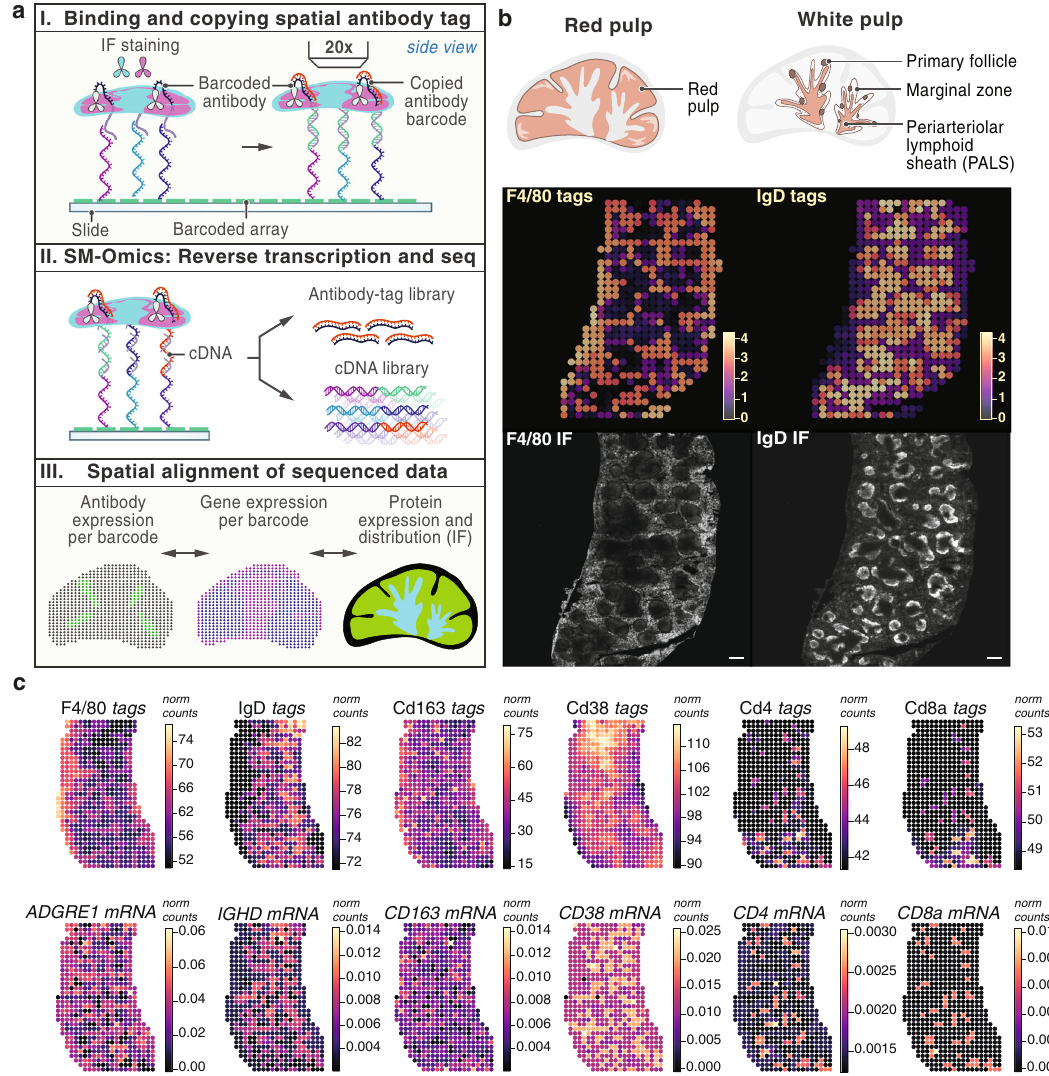
Fig. 4 Spatial RNA-Seq and protein pro fi ling with DNA-barcoded antibodies in mouse splenic tissue. a Experimental setup. SM-Omics approach combines automated imaging of IF antibody stained tissue sections, tagging antigens spatially in situ using DNA-barcoded antibodies and capturing mRNA on a spatially barcoded poly(d)T array. Frozen tissue sections are placed on a SM-Omics array, tissues stained with both IF and DNA-barcoded antibodies, imaged and in situ copying reactions performed and at the same time as cDNA is made (I). Then, both the antibody tags and cDNAs are used in the library preparation reactions and sequenced (II). Finally, spatial IF, antibody tag and gene expression patterns can be evaluated (III). b Performance of combined antibody IF and DNA-barcoded antibody signal measurements. Splenic tissue illustration of red and white pulp structures (top) followed by spatial expression pro fi les of sequenced antibody tags (middle; normalized expression shown in color scale) as well as IF images (bottom) in splenic tissue for F4/ 80 staining red pulp macrophages and IgD staining marginal zone B cells in the white pulp ( n = 7). Scale bar (bottom) denotes 300 µ m. c Performance of combined DNA-barcoded antibody signal and spatial transcriptomics measurements. Spatial expression pro fi les (normalized expression shown in color scale) for a 6-plex SM-Omics reaction with F4/80, IgD, Cd163, Cd38, Cd4 and Cd8a DNA-barcoded antibody-based expression in the top panel (tags) and respective gene expression shown in the bottom panel patterns (Fig. 4b) that were well-correlated to the corresponding both detection methods. We imaged the fl uorescently labeled IF intensities across all major splenic regions (Supplementary epitopes prior to any in situ enzymatic reactions on the array Fig. 10a, on average 76%, p ≤ 0.0001). RNA and antibody tag surface, coupled the antibody tags to the spatial array, such that levels were in agreement for IgD (Spearman ’ s ρ = 0.73, n = 3, they were copied into a stable covalent complex, while mRNA p -value ≤ 0.05 across all spatial measurements), and less so for F4/ was spatially captured and transcribed on the array (Fig. 4a). 80 (Spearman ’ s ρ = 0.65, n = 3, p -value ≤ 0.05 across all spatial We fi rst tested a two-antibody cocktail targeting F4/80 and IgD measurements) (Supplementary Fig. 10b). (Fig. 4b), aimed to stain distinct spatial niches in the mouse spleen: splenic red pulp macrophages and marginal zone B cells barcoded antibodies targeting F4/80, IgD, Cd163, Cd38, Cd4, and in the white pulp, as previously described 19 . We obtained high quality antibody tag (mean ± sd 142 ± 15 UMIs per SM-Omics Cd8a (Supplementary Fig. 10c), spanning different levels of measurement; n = 7) and cDNA libraries (1375 ± 181 UMIs per expression and spatial patterns, successfully combined spatial SM-Omics measurement, n = 3), with highly speci fi c antibody tag transcriptomics and protein estimates in a highly multiplexed